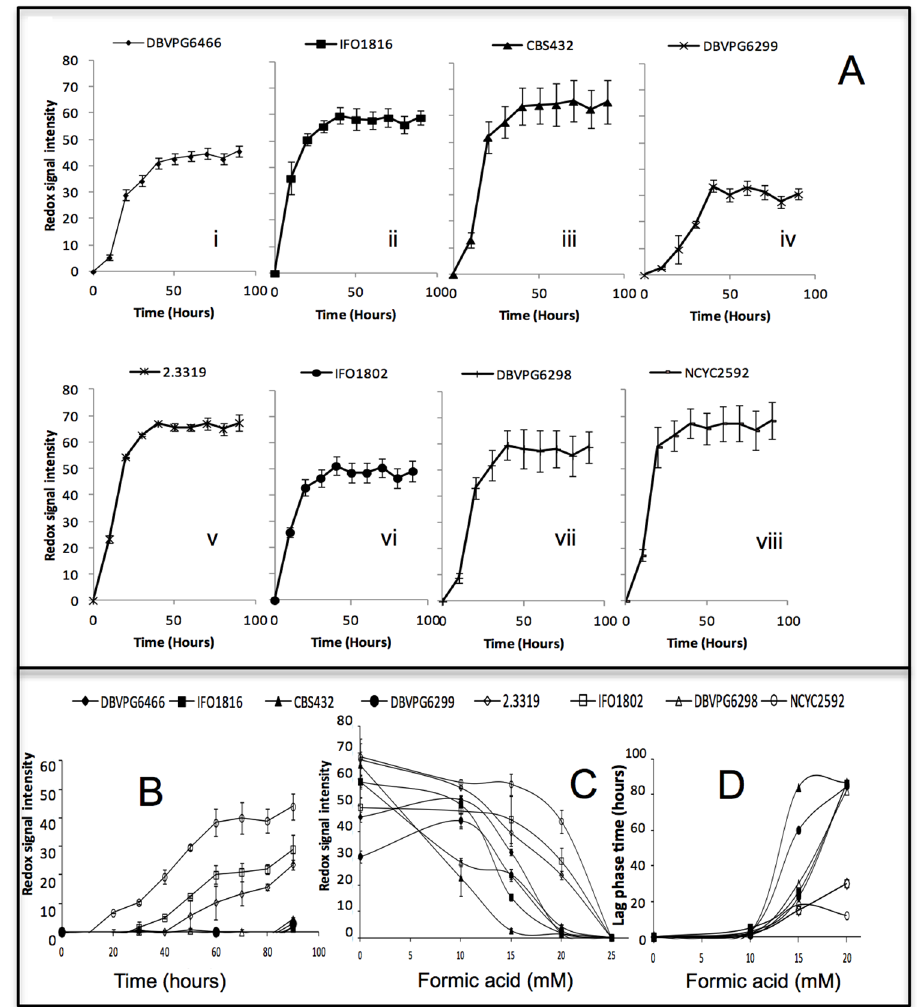
Fig 2. Metabolic output profiles of Saccharomyces spp on media containing formic acid (0 – 20 mM) incubated at 30°C under anaerobic conditions. (A) Control (0 mM) media without formic acid. (B) Formic acid 20 media. (C) Duration of lag phase in PM at formic acid 0,10,15 and 20 mM media. (D) Maximum redox signal intensity after 90 hours at formic acid 0, 10, 15, 20 and 25 mM media. Error bars represent the standard deviation of 3 replicates (Biolog unit = redox signal